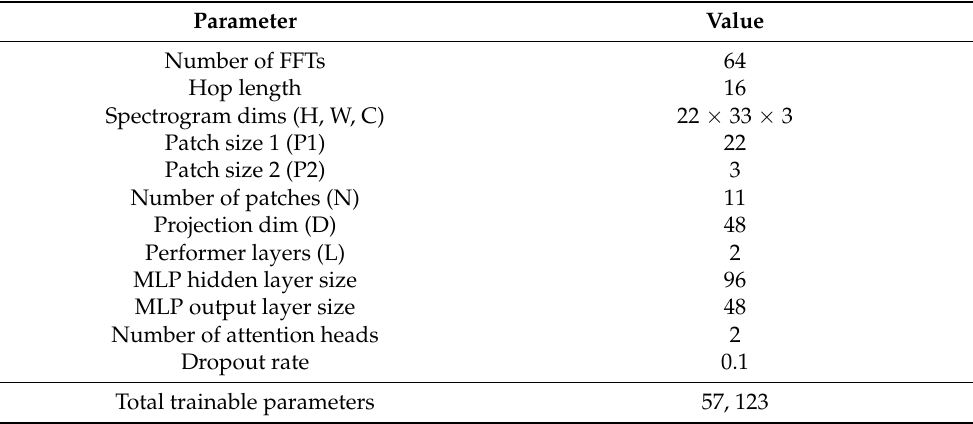
Table 1. The Seismo-Performer model configuration